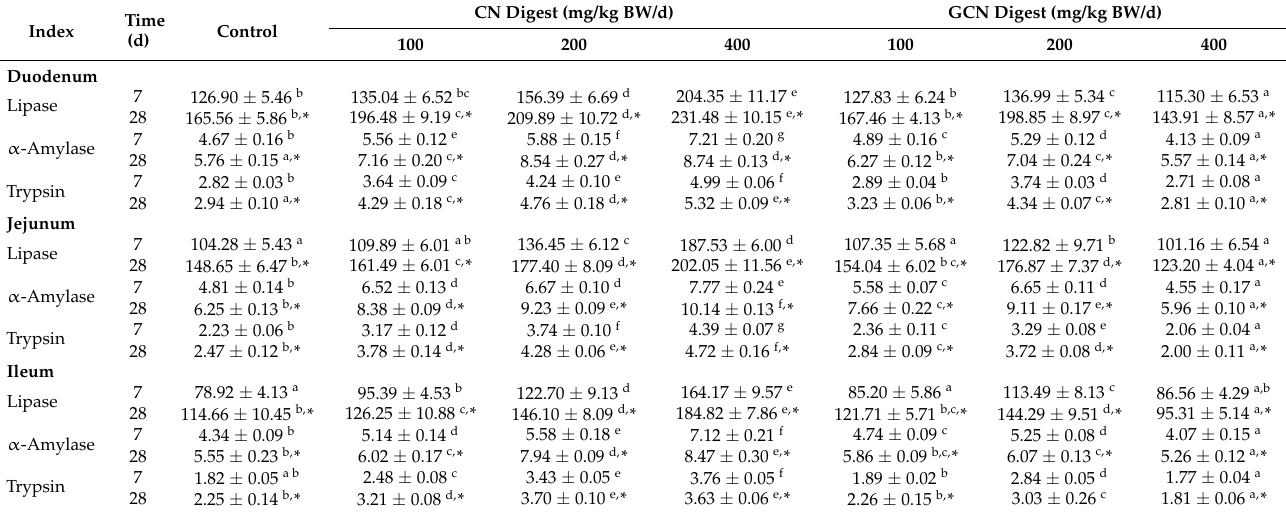
Figure 2. The histological pictures ( a – c ) and calculated villus height/crypt depth ( d – f ) of the duodenum specimens obtained from the control rats ( a , d ), the rat fed with CN digest ( b , e ) or GCN digest ( c , f ) at dose level of 400 mg/kg BW/d. Values are reported as means ± standard deviations ( n = 6), while different lowercase letters above the columns indicate that one-way ANOVA of the means differs significantly ( p < 0.05). CN: caseinate; GCN: glycated caseinate; control: rats fed with 0.9% NaCl; CN1, CN2, and CN3: rats fed with 100, 200, and 400 mg/kg BW/d of CN digest, respectively; GCN1, GCN2, and GCN3: rats fed with 100, 200, and 400 mg/kg BW/d of GCN digest, respectively. Table 1. Measured activities 1 of digestive enzymes of the rats in response to the intake of caseinate (CN) digest and glycated caseinate (GCN)